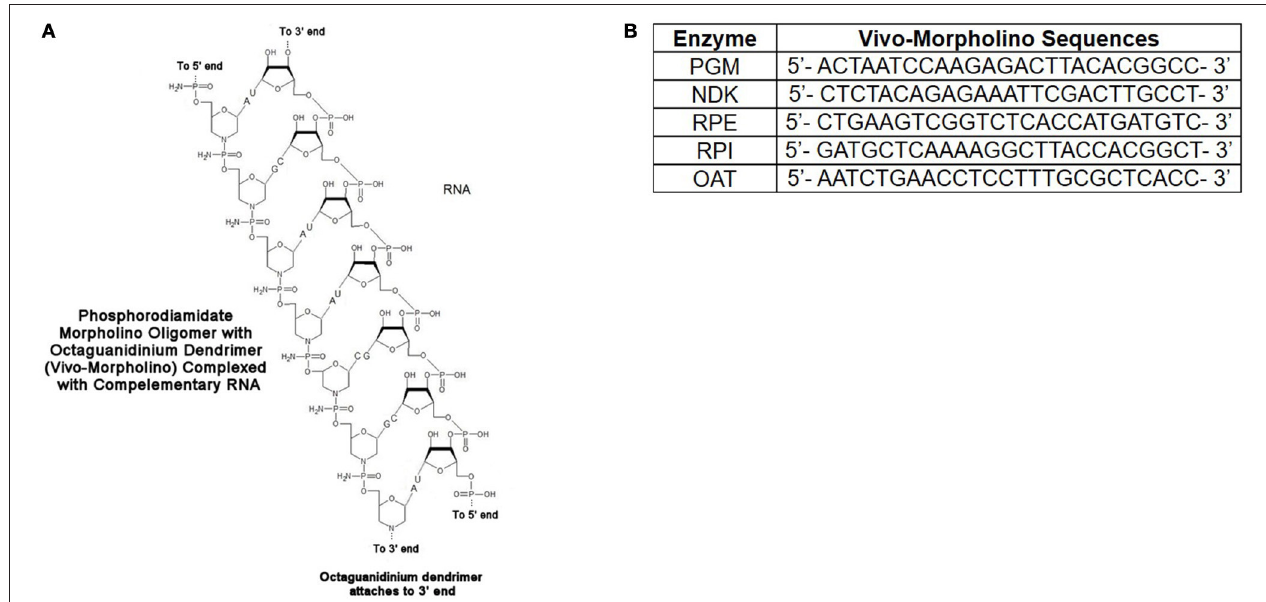
FIGURE 7 | (A) Schematic of Interaction Between vivoPMO and RNA. (B) Sequences for PMO. Sequences for all enzymes were designed to be complementary to regions overlapping splice sites so as to prevent appropriate interaction between mRNA and the spliceosome predicted to lead to the production of a non-functional protein